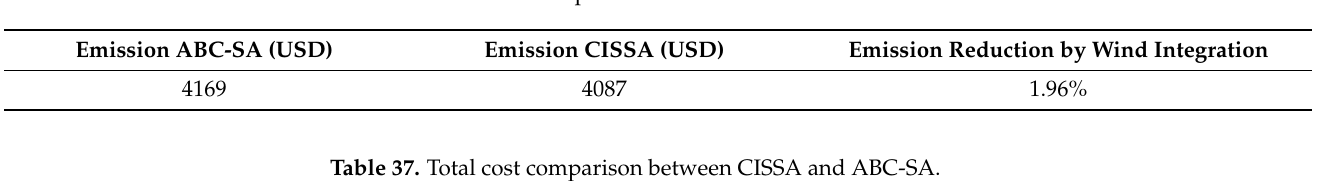
Table 36. Emissions comparison between CISSA and ABC-SA.